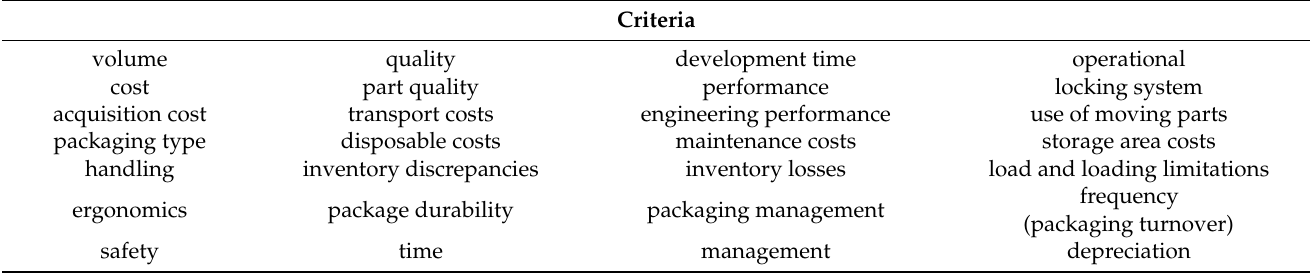
Table 3. List of criteria listed in the brainstorming